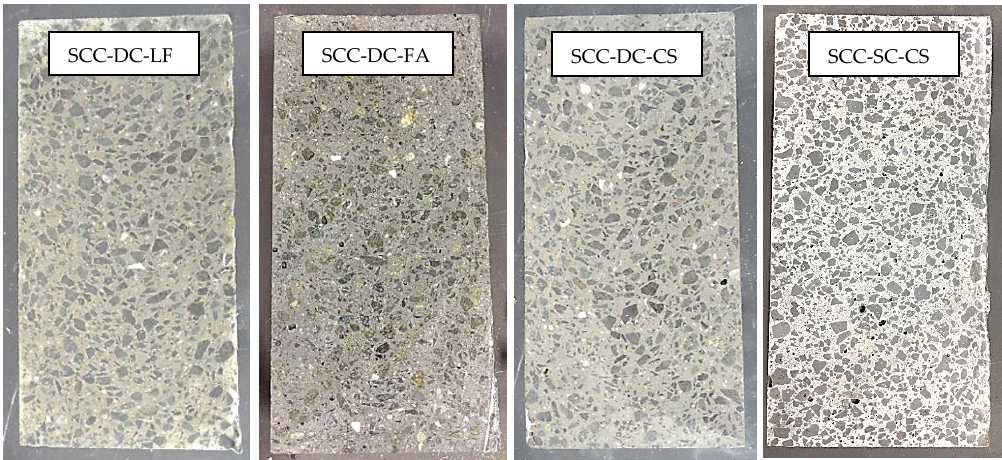
Figure 3. Appearance of the concrete mixes.